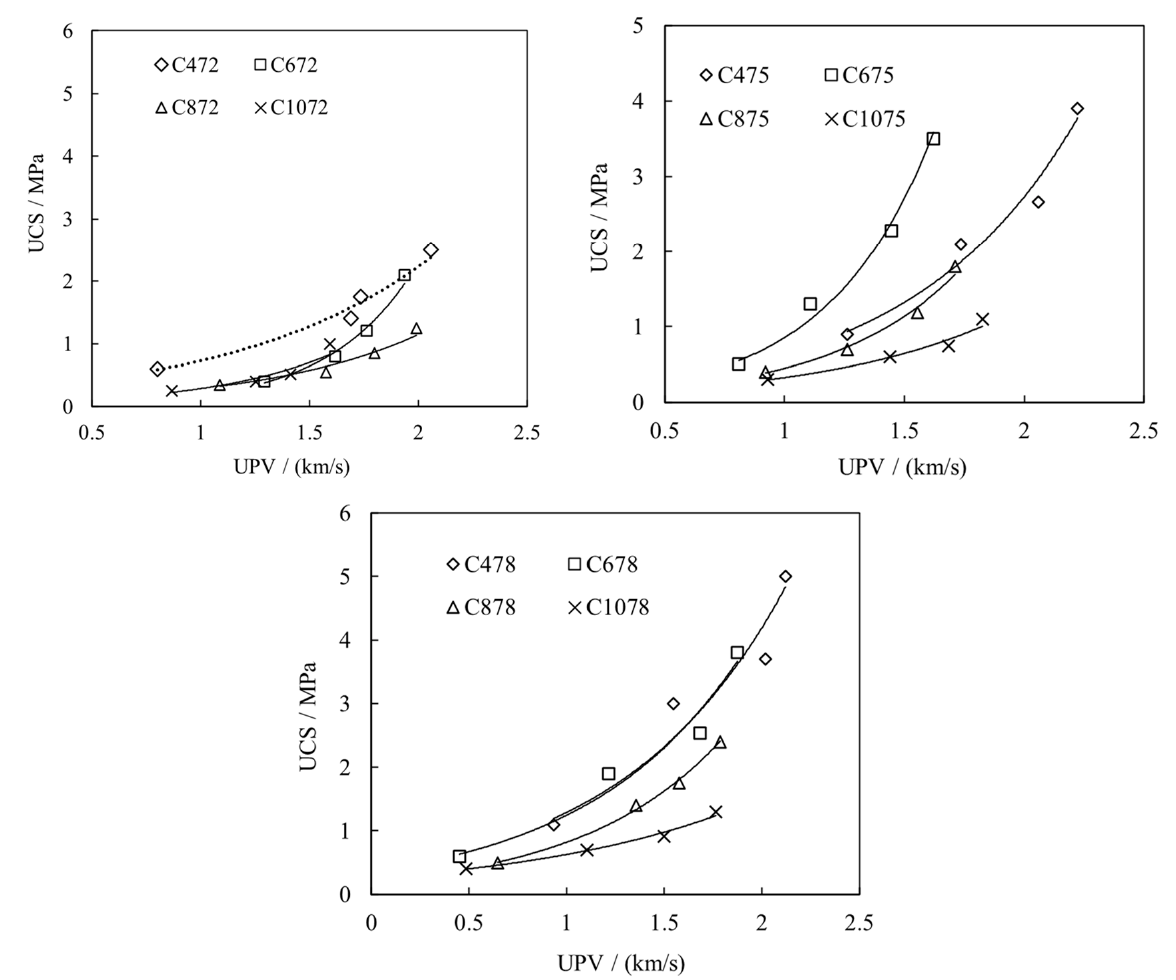
Figure 12. Relationship between UCS and UPV of CTB.